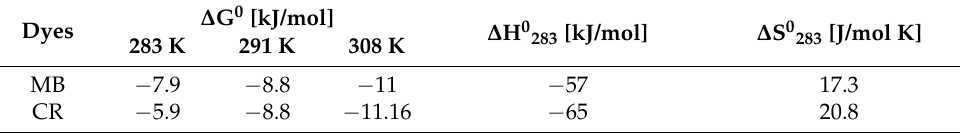
Table 3. Thermodynamic parameters for the adsorption of the dyes on the sorbent.